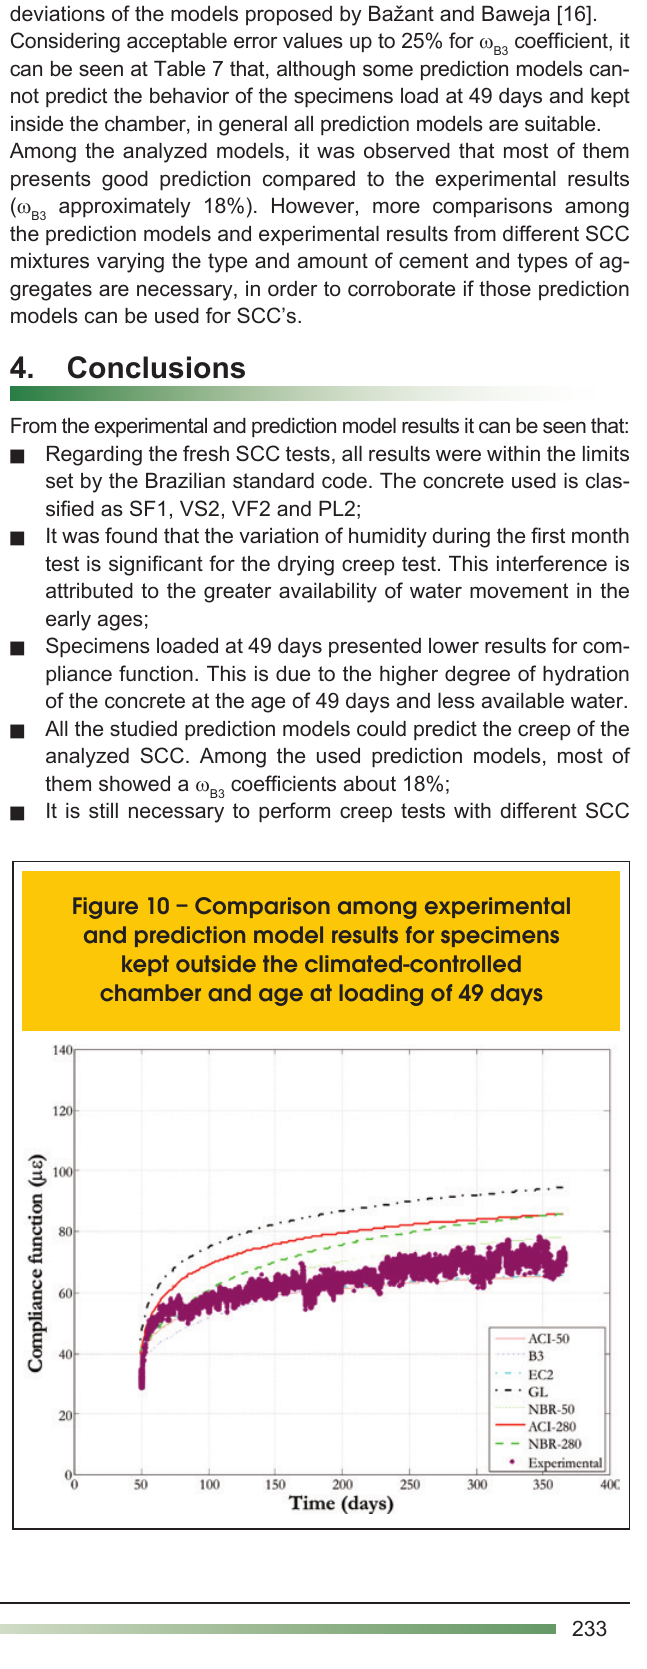
Figure 9 – Comparison among experimental and prediction model results for specimens kept inside the climated-controlled chamber and age at loading of 49 days